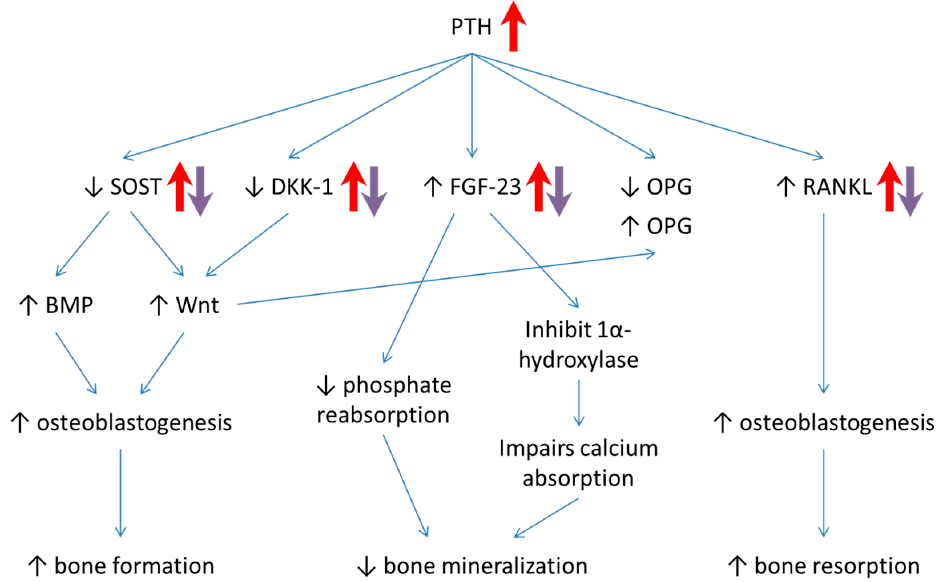
Figure 4. The postulated role of osteocyte-derived bone peptides (OPG, sRANKL, SOST, DKK-1, FGF-23, and PTH) in regulating bone remodelling processes. The red arrows indicate the protein levels in rats after challenged with HCHF diet for 20 weeks. The purple arrows indicate the protein levels in rats in response to the treatment with tocotrienol.